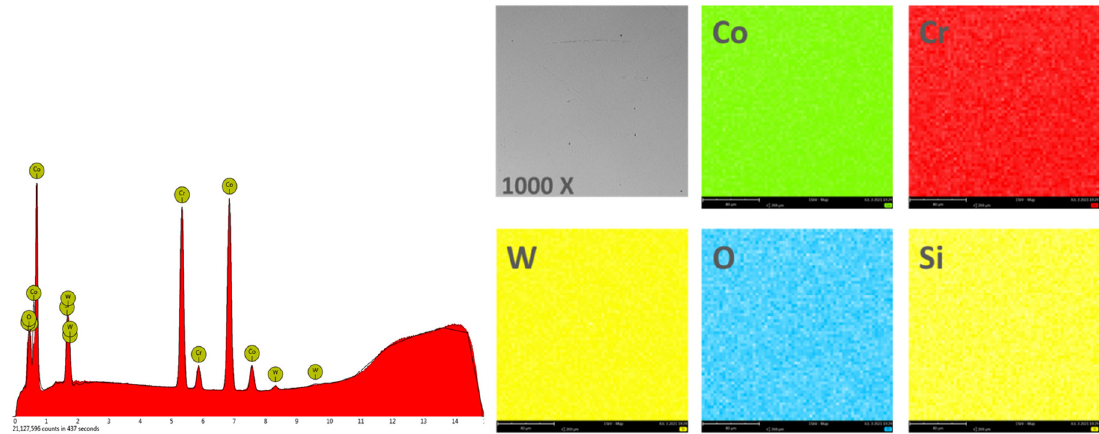
Figure 5. EDS spectra and elemental distribution for CCm samples.